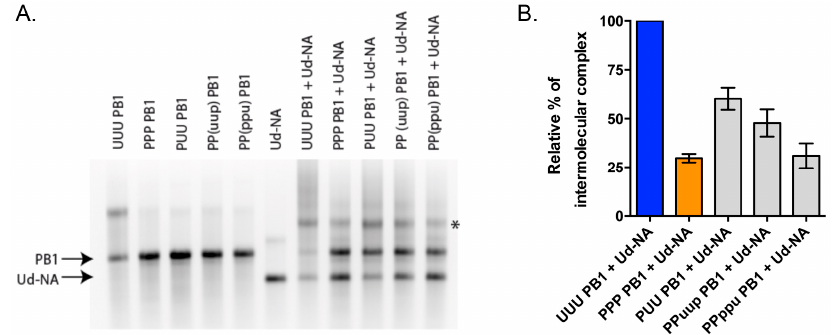
Figure 8. In vitro analysis of the interaction between Udorn NA vRNA and wild-type or chimeric PB1 vRNAs. ( A ) Analysis by native gel electrophoresis. Monomeric NA or PB1 vRNAs are indicated by arrows and the intermolecular complexes are marked by an asterisk; ( B ) Relative percentage of intermolecular complex. The weight fraction (%) of the RNA migrating as an intermolecular complex was calculated by dividing the weight fraction of the corresponding band by the sum of the weight fractions of all bands in the lane and normalized to the complex formed between wild-type (UUU) PB1 and Udorn NA vRNAs set to 100%. Data represent mean ± standard error ( n =